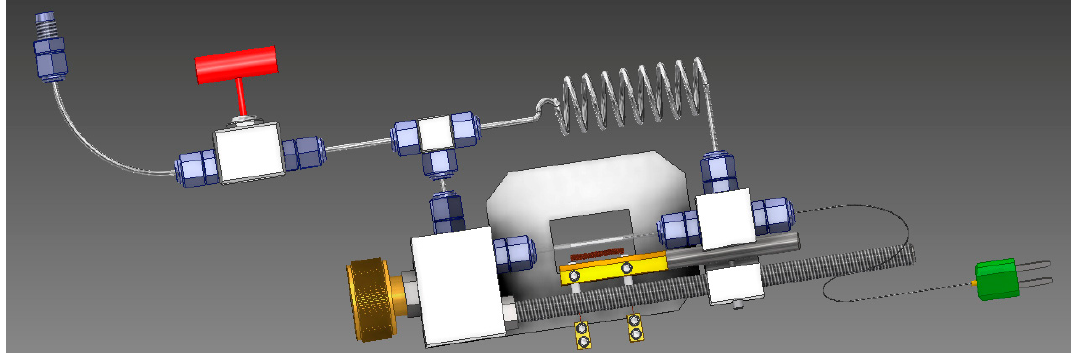
Figure 2. High-pressure sample holder used for in situ synchrotron data collection.